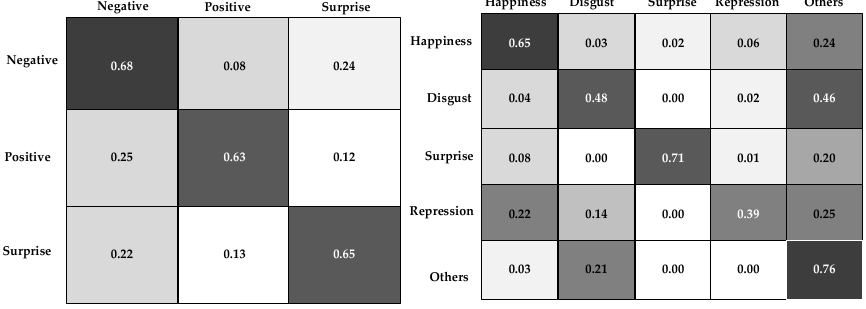
Figure 7. The confusion matrix of OFF2BD on SMIC and CASME II.